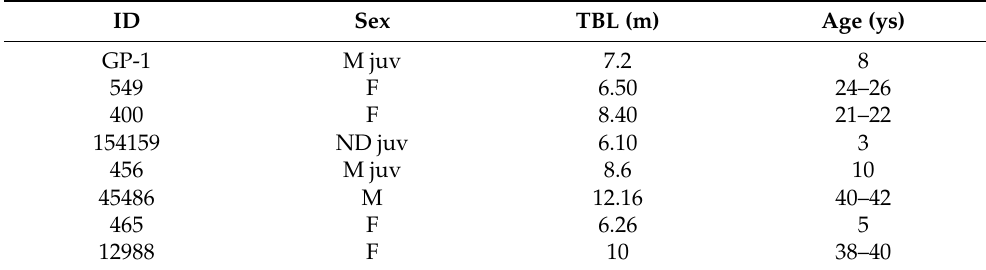
Table 3. ID number, sex, total body length (TBL) and age of P. macrocephalus specimens examined in this study. ND: undetermined